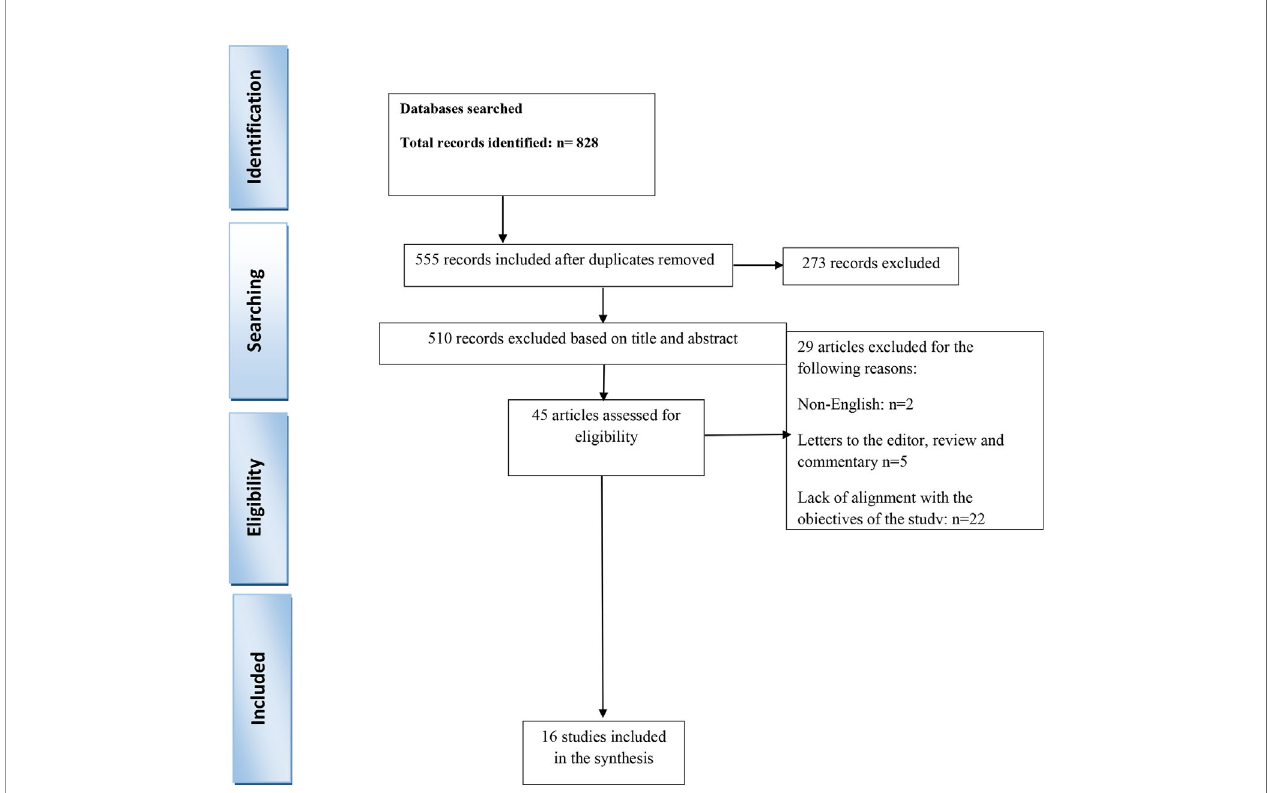
FIGURE 1 | Study fl ow